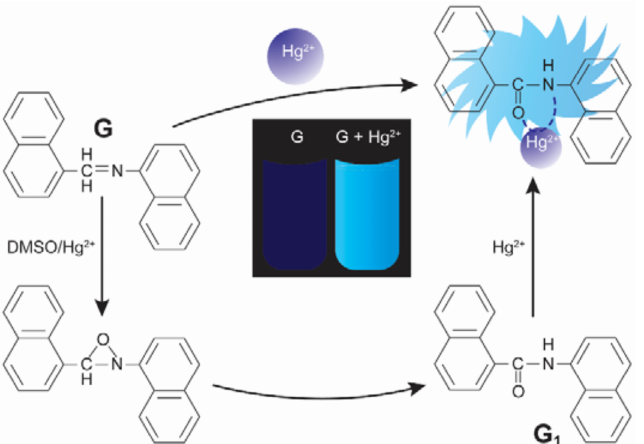
Figure 16. Double-naphthalene Schiff base chemosensor (G) toward Hg 2+ probing in DMSO solution. Reproduced with permission from [39] by